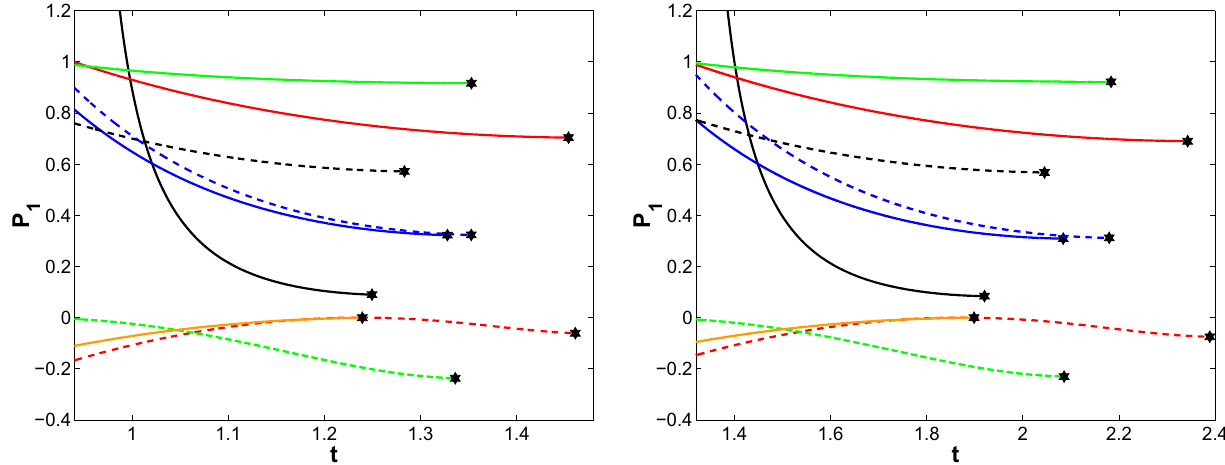
Fig. 2 The final stage of the evolution of the dimensionless parameter P 1 ( t ) for N = 2, f 0 = 1 of H a ( 0 ) , H b ( 0 ) are chosen as in Fig. 1 (see the corresponding colors and types of line). The black star denotes the moment of a cosmological